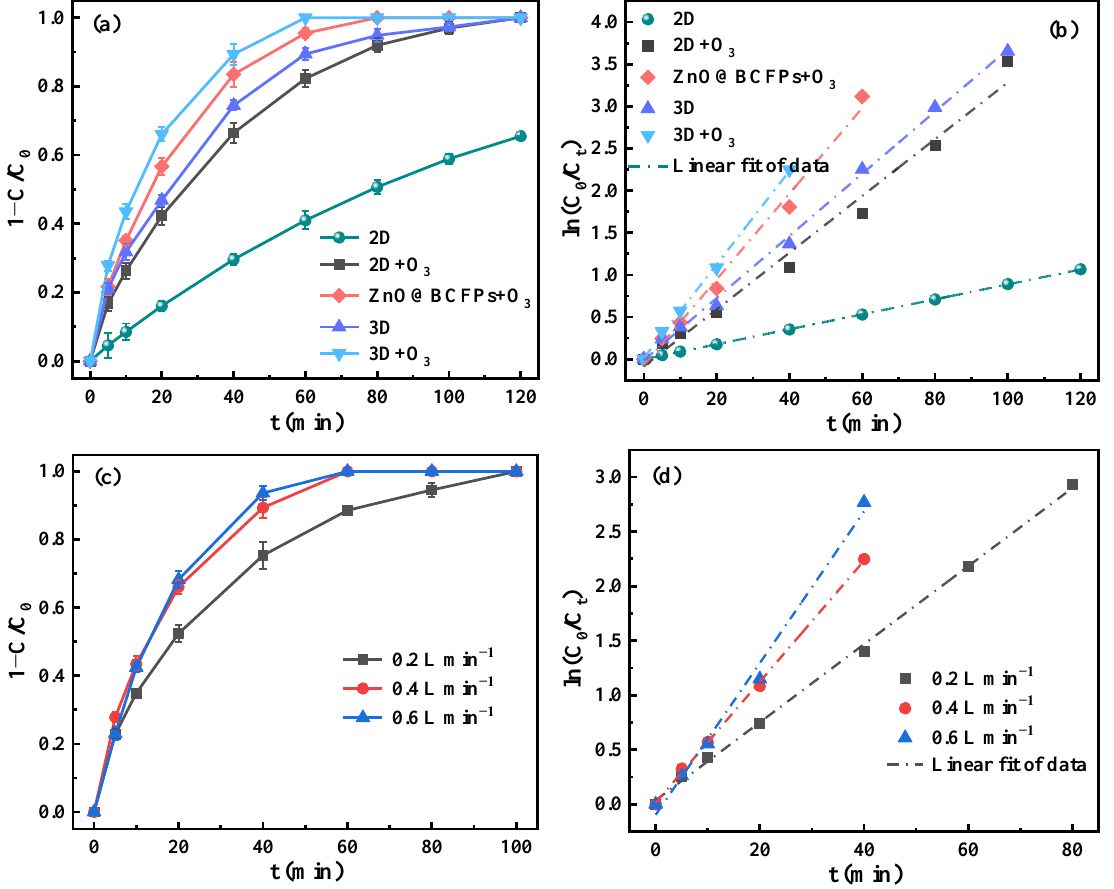
Figure 8. Comparison of removal efficiency in different systems ( a ) and ( b ); Effect of O 3 aeration rate on removal efficiency ( c ) and ( d ). ([metronidazole] 0 = 15 mg L −1 , [Na 2 SO 4 ] 0 = 0.05 mol L −1 , current density = 8.00 mA cm −2 , dosage = 10.00 g L −1 , pH = 7).